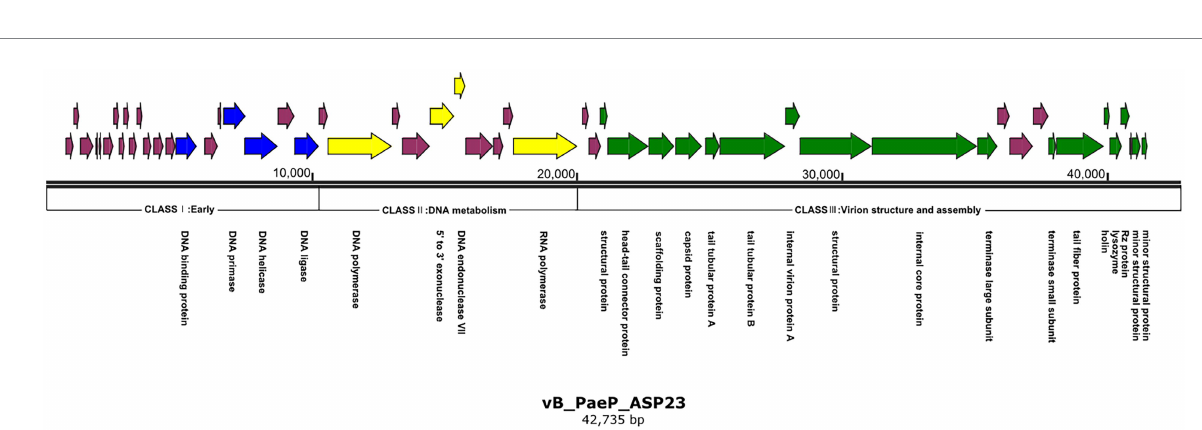
FIGURE 3 Genome map of phage ASP23. Nucleotide sequences were analyzed using SnapGene and predicted open reading frames are denoted by arrows. Genes were classified into different clusters: early genes (blue), genes involved in DNA metabolism (yellow), genes involved in virion structure and assembly (green), genes encoding hypothetical proteins